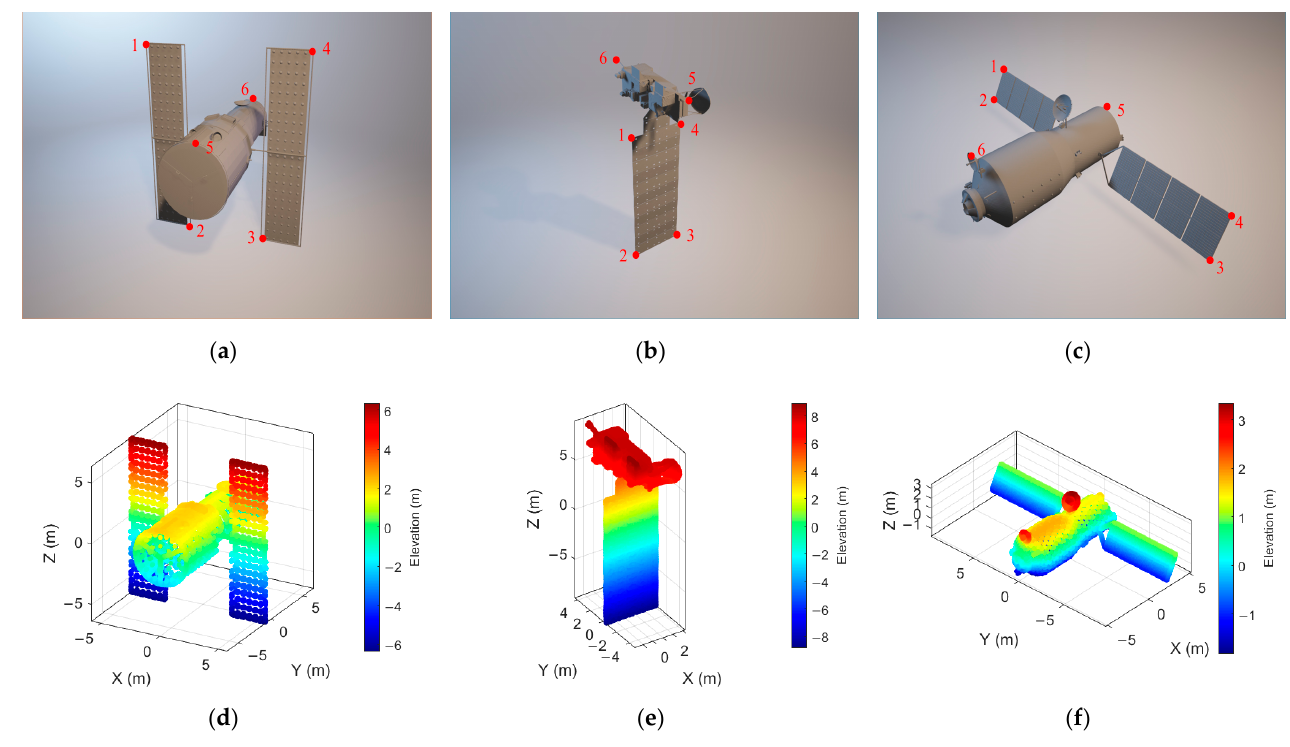
Table 1. The motion parameters of different targets.